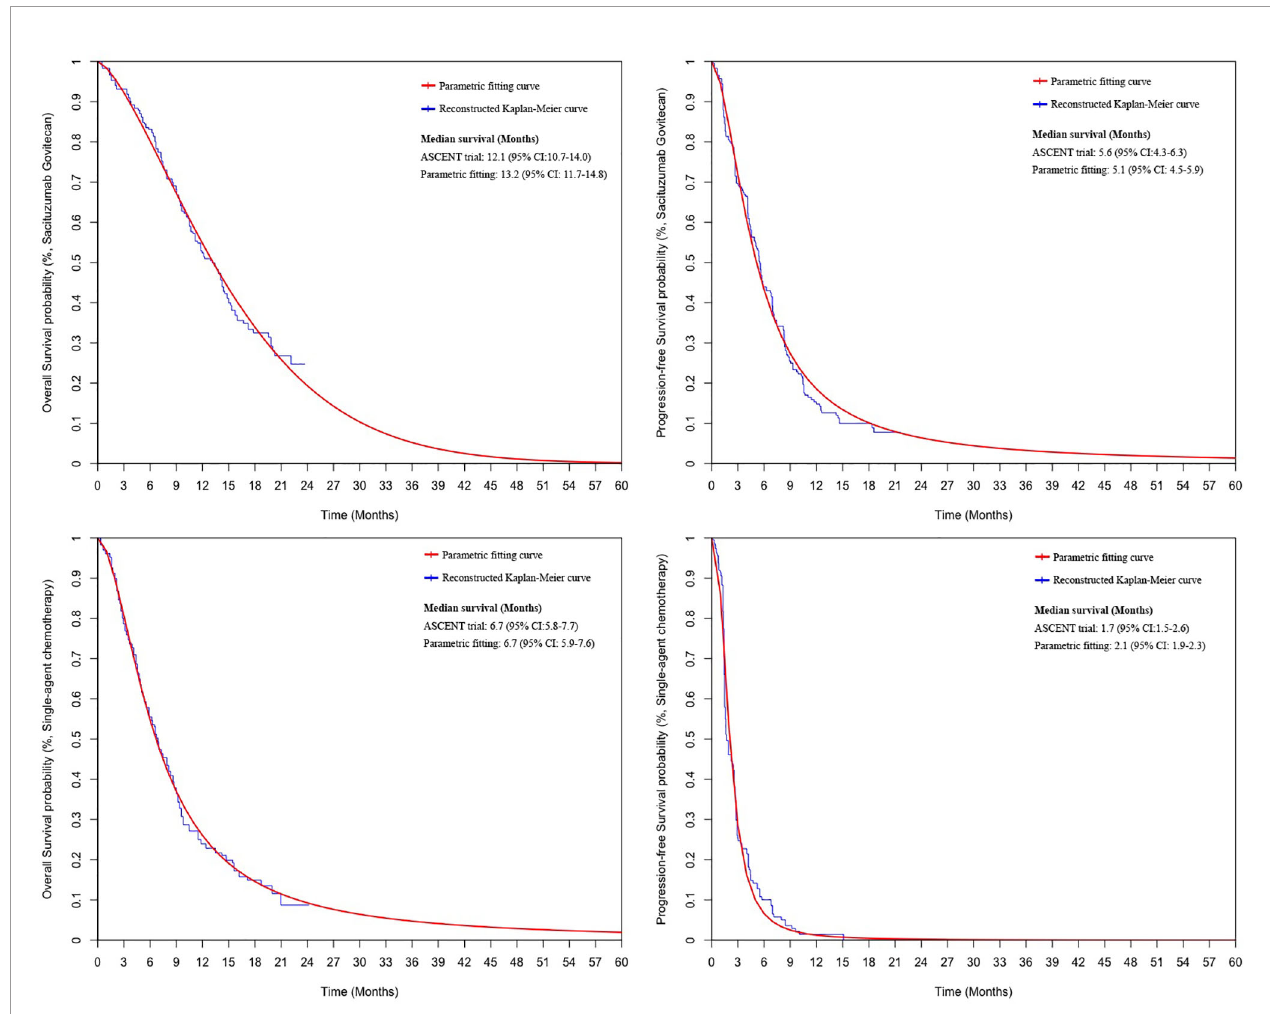
FIGURE 1 | The comparison between the reconstructed Kaplan-Meier curves from the ASCENT trial and the best parametric fi tting curves. CI: con fi dence